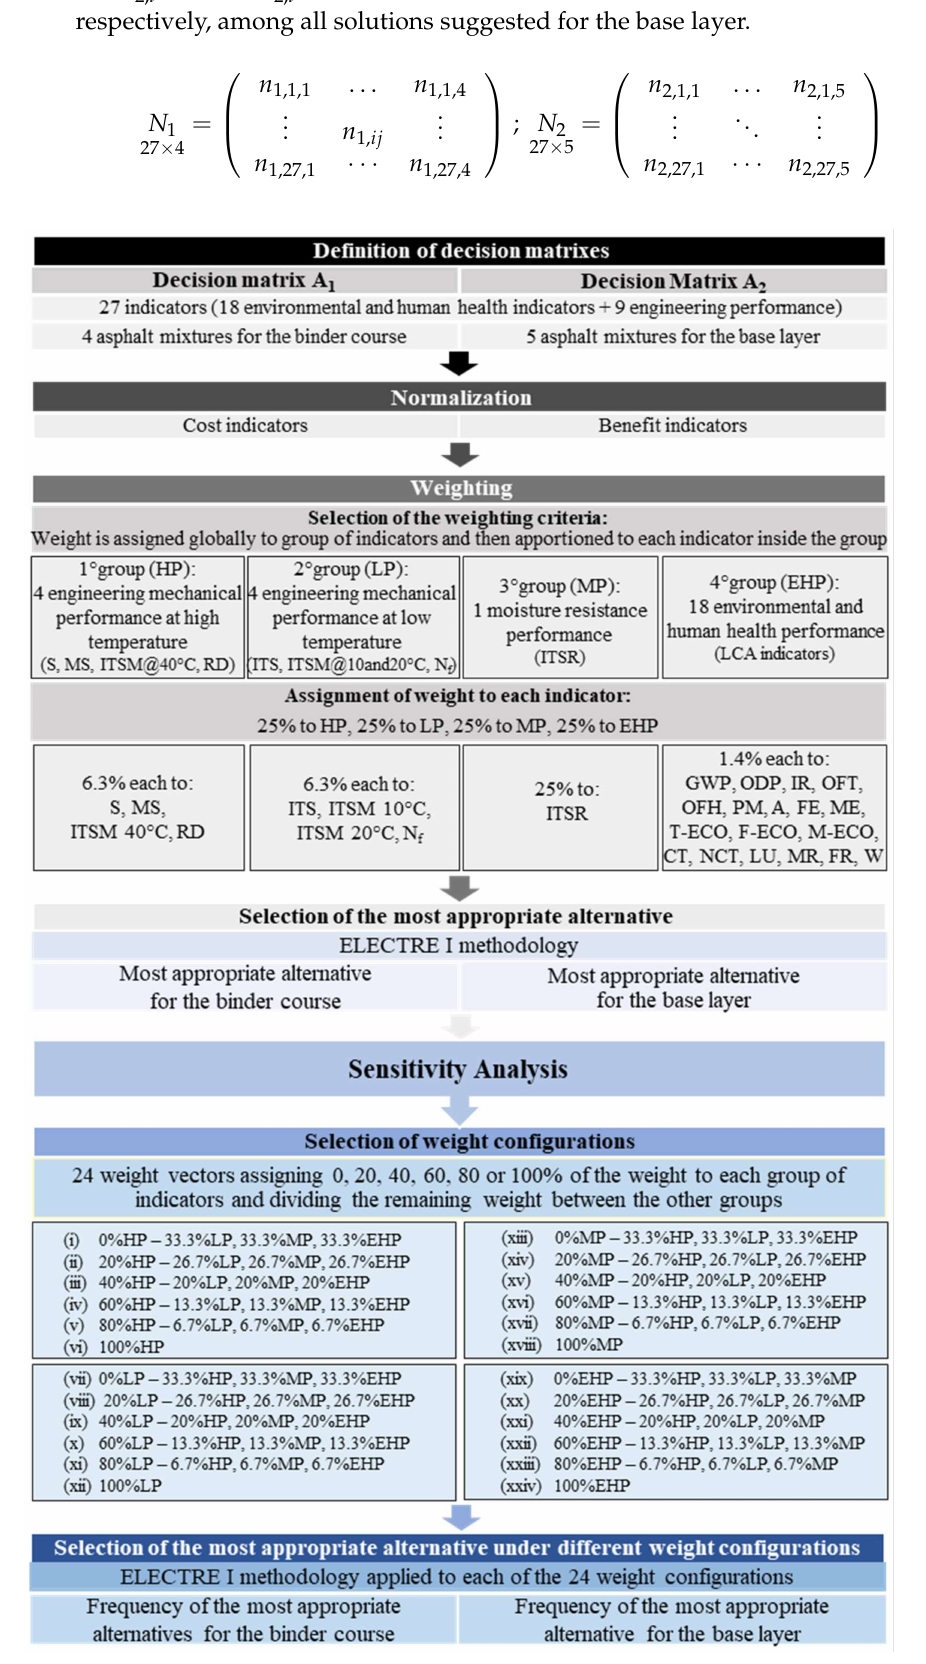
Figure 2. Workflow diagrams describing the MCDA and sensitivity analysis